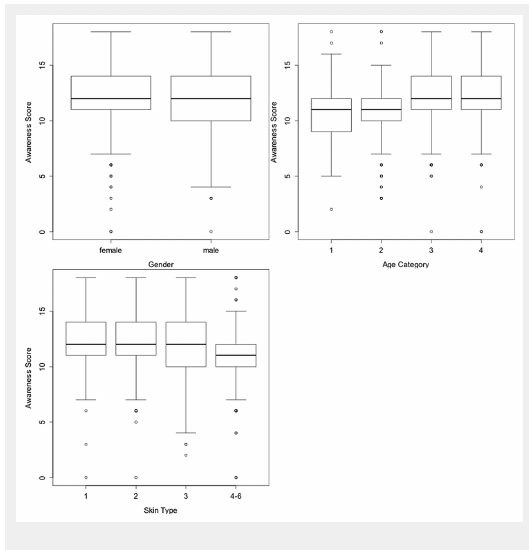
Box plots of the skin cancer awareness score and the gender, the age category and the skin type of the participants, univariate level. The correlation between the skin cancer awareness score and gender, age category, and skin type were statistically significant (for individual p-values refer to table 2). Four age categories were made, based on the year of birth of the athletes: category 1 (18–24 years), category 2 (25–34 years), category 3 (35–54 years) and category 4 (≥55 years). The skin type was divided into four different groups: Category 1 (Fitzpatrick skin type I), category 2 (Fitzpatrick skin type II), category 3